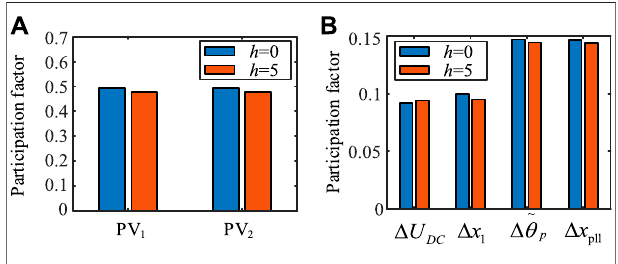
FIGURE 13 | (A) Participation factor of ~ λ 1 , (B) Participation of the state variables in ~ λ 1 .